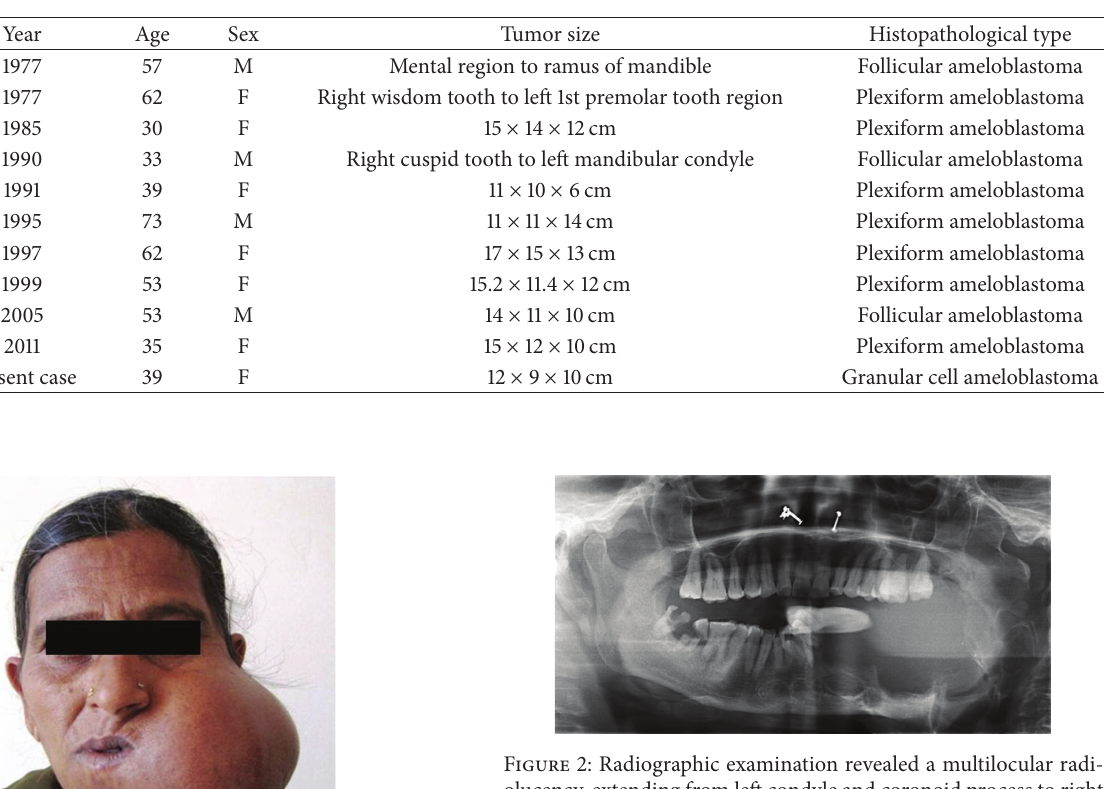
Table 2: A review of clinical features, tumor size, and histopathological type of giant ameloblastomas that were previously reported and the present case.